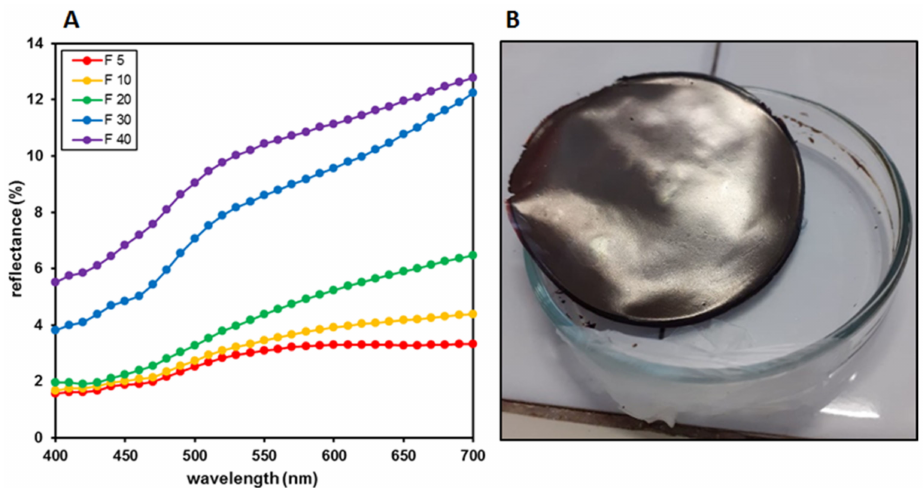
Figure 4. ( A ) Reflectance curves of films F 5 , F 10 , F 20 , F 30 and F 40 . ( B ) Photograph of F 40 film showing the mirror effect observed after the heat drying step. Table 3. Colorimetric parameters of heat dried films F 5 , F 10 , F 20 , F 30 and F 40 . Film